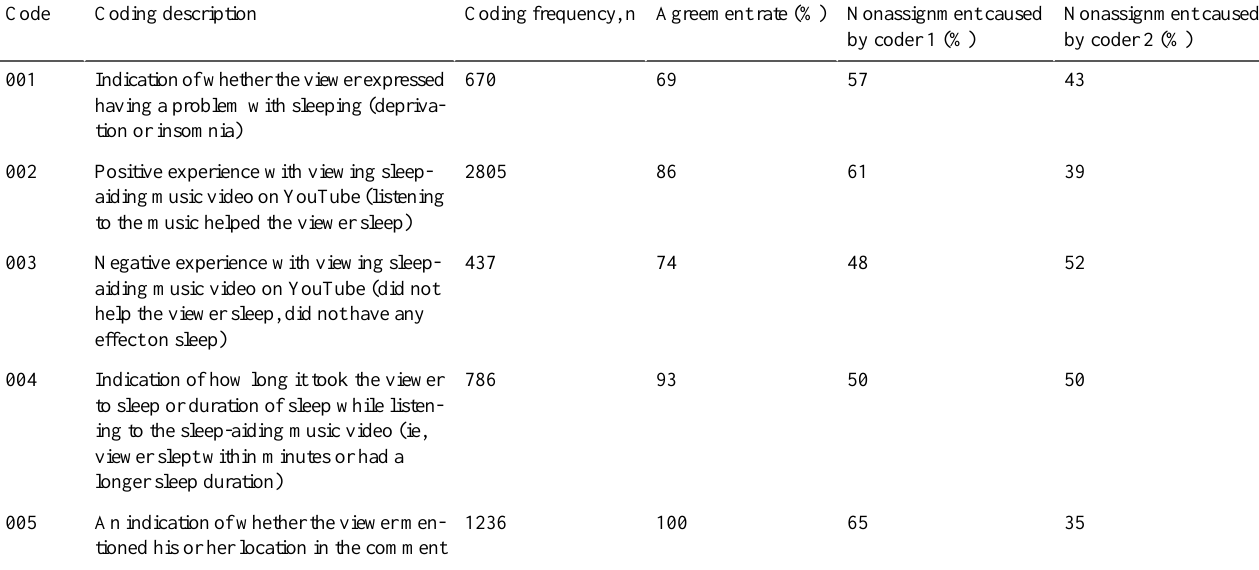
Table 3. Comments coding frequency, agreement rate, and percentage of nonassignment by coders a